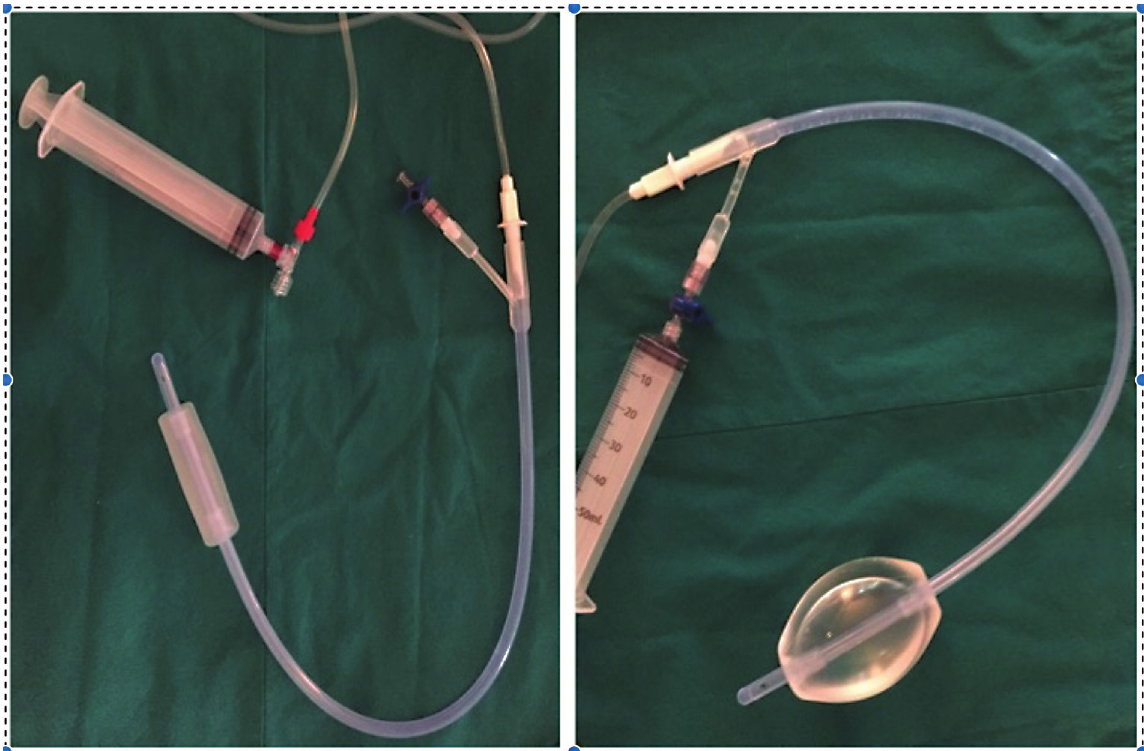
Fig. 3 Bakri catheter before and after being fi lled with